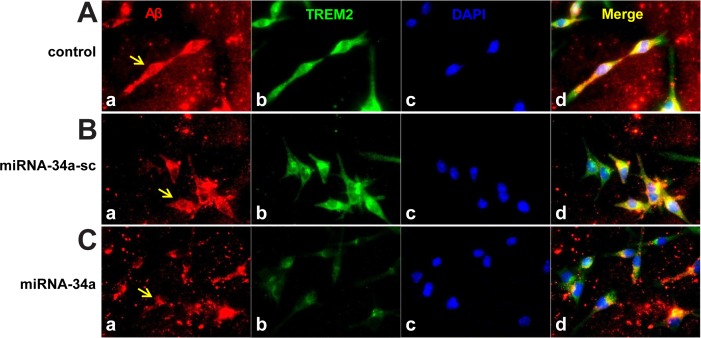
Control C8B4 murine MG cells efficiently phagocytose Aβ42 peptides; miRNA-34a treated MG cells do not; (A) C8B4 MG cells (ATCC CRL-2540) were cultured for 3 days (control a-d, top row); cells were treated with 5 μM of Aβ42 for 24 hr before staining; Aβ42 peptide (American Peptide Company, Sunnyvale, CA, cat # 62-0-80A); Aβ42 peptide was prepared as previously described [33]; briefly, Aβ42 peptides were initially solubilized in hexafluoroisopropanol (HFIP; Fluka Chemical, cat# 52512; Sigma-Aldrich, St. Louis MO), aliquoted, and stored at −20°C as an HFIP film. After vacuum evaporation of HFIP, aliquoted peptide was re-suspended with DMSO to 5 mM and diluted to 5 μM into the cell culture media; (B) cells were treated with a scrambled miRNA-34a sequence (miRNA-34a-sc; 30 nM;, control, a-d, middle row); or (C) with an LNA-stabilized miRNA-34a (30 nM; miRNA-34a stressed; a-d; bottom row); treatments were for 24 hr before incubation with 5 uM of Aβ42 (made up as in [33]) for another 24 hr before assay; MG cells were subsequently stained using a murine amyloid beta MABN10 (red fluorescence λmax~650 nm; anti-Aβ antibody, clone W0-2; Millipore, Bellerica MA), a TREM-2 antibody (M-227): sc-48765 (green fluorescence; λmax~510 nm; Santa Cruz, Santa Cruz CA) or DAPI nuclear stain (blue fluorescence; λmax~470 nm) as in Fig 3; arrows indicate Aβ42 uptake into MG cells; note decreased presence of TREM2 in miRNA-34a treated MG cells (bottom row, panel B) and decrease in ingested Aβ42 peptide within C8B4 cells (C; bottom row, panel d). Taken together these results support a miRNA-34a-mediated impairment of sufficient TREM2 to phagocytose Aβ42 peptide from the extracellular space; note self-aggregation of Aβ42 peptide after 24 hrs and Aβ42 peptide affinity for TREM2 containing cells (leftmost panels) and internalization (rightmost panel; yellow merge; λmax~580 nm); magnification 20x; Aβ peptide quantification was performed using SlideBook 5.0 (Intelligent Imaging Innovations) and ImageJ (NIH) software; under these conditions about 42% of externalized Aβ42 was cleared; additional relevant methods have been described [10,44].